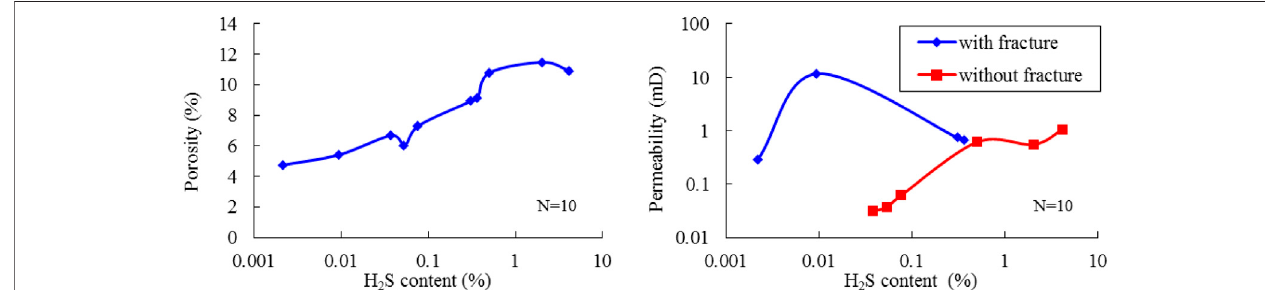
FIGURE 11 | Relationship between reservoir physical properties and H 2 S contents.